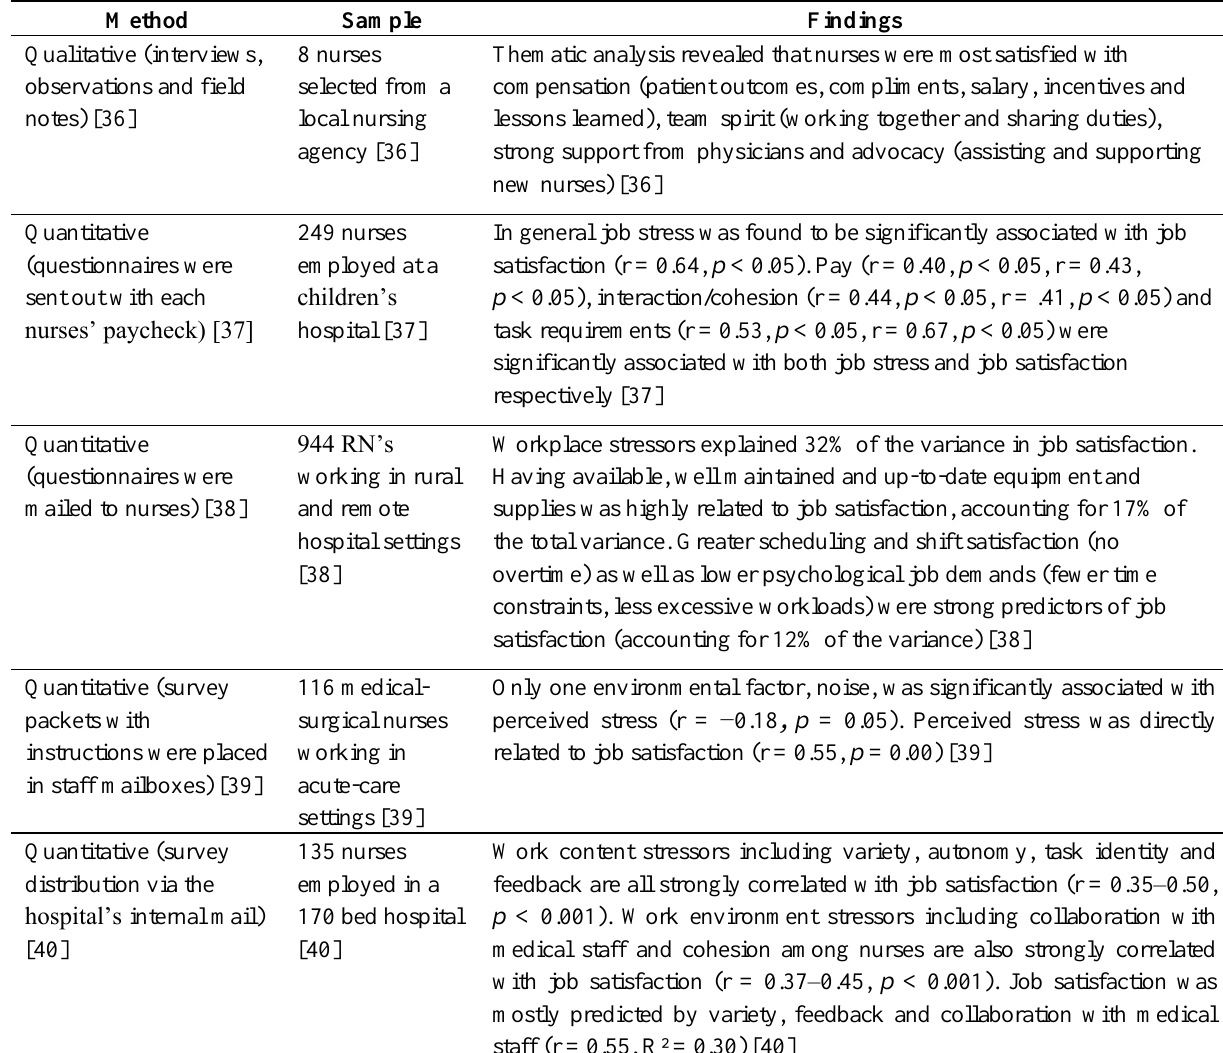
Table 2. Method, sample and findings of identified